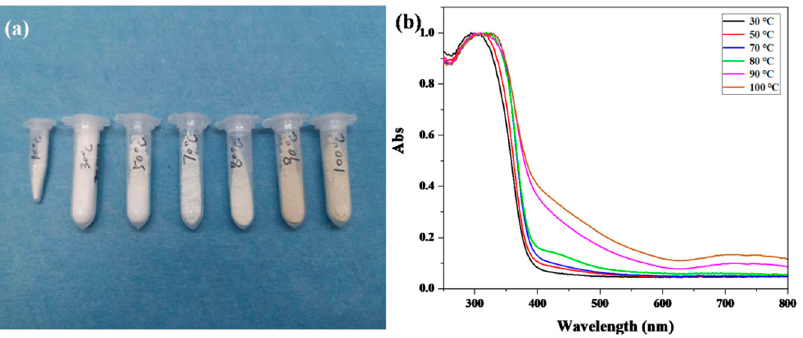
Figure 8. ( a ) Color change diagram of different samples, ( b ) typical UV–vis DRS of the sample with different synthesis temperatures.